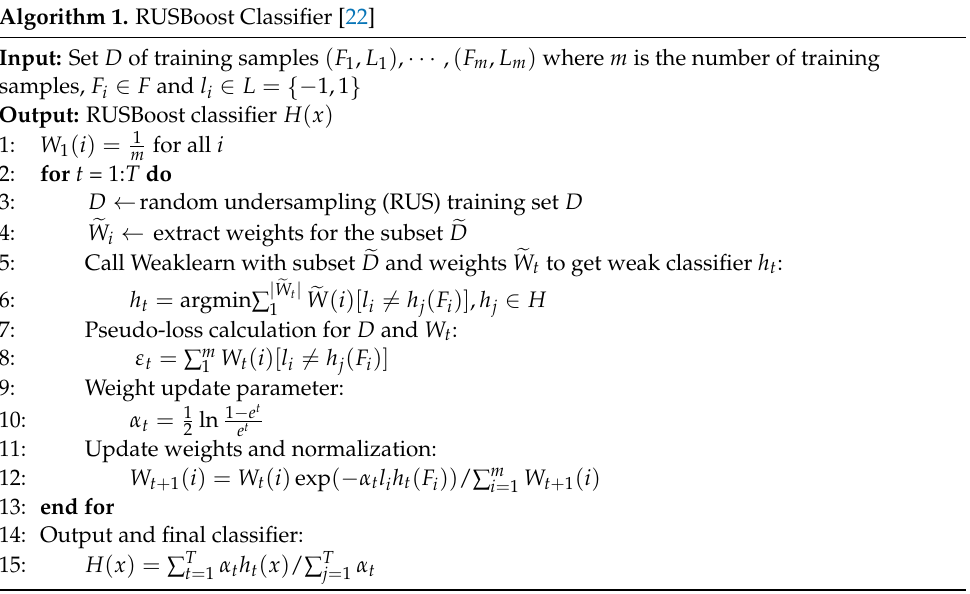
Algorithm 1. RUSBoost Classifier